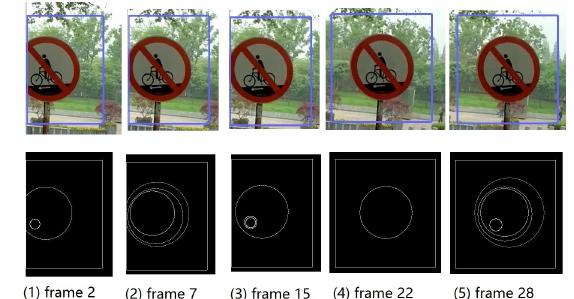
not enough to fit a ellipse. 2.The thickness of the edge affect- s the inner class and the outline class.This may fit a new ellipse between two layers or more than two edges.